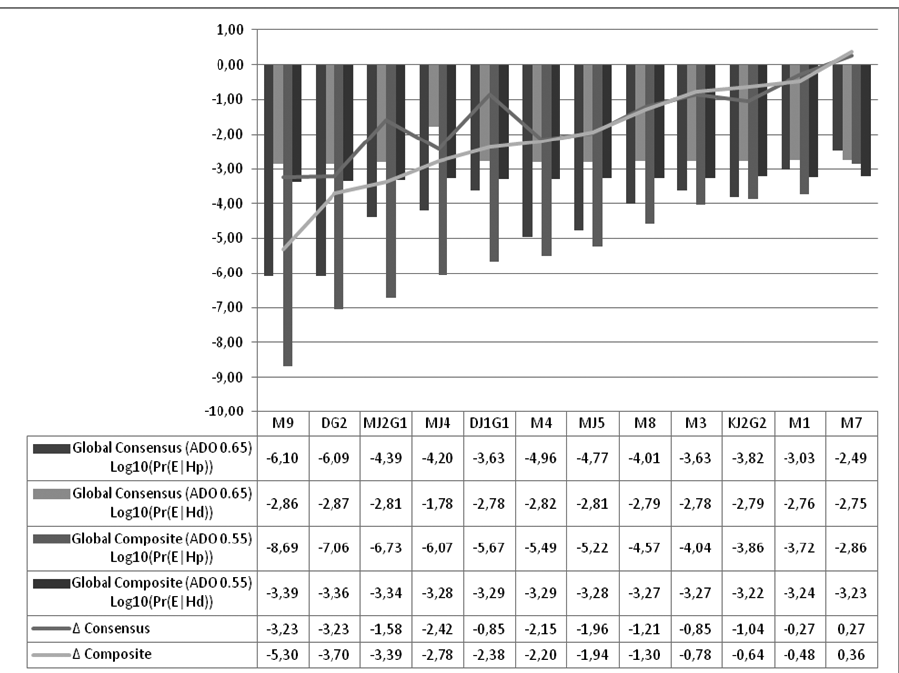
Figure 2. Test for the veracity of the prosecution hypothesis. Likelihood ratio of the prosecution hypoth- esis (Log10(Pr(E|Hp))) versus the defense hypothesis (Log10(Pr(E|Hd))) for each suspected male. The Δ value gives an idea of the veracity of the hypothesis